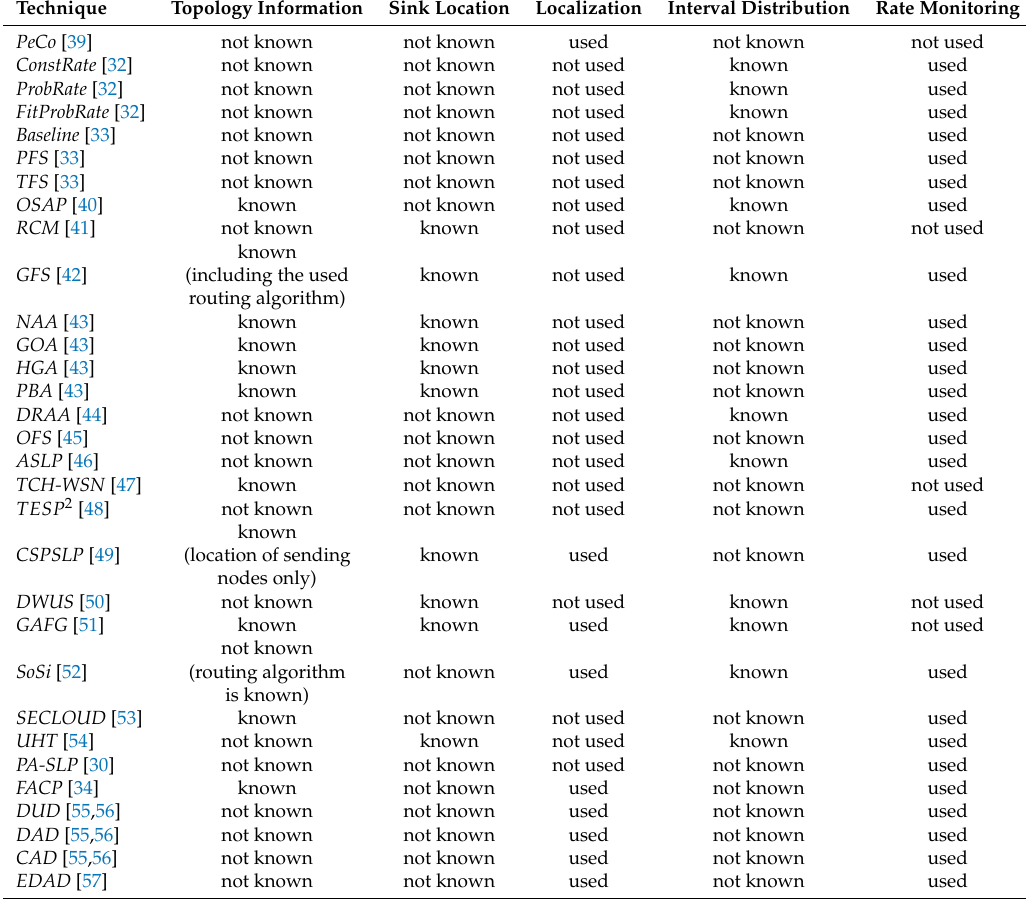
Table 2. Comparison of global adversary models.